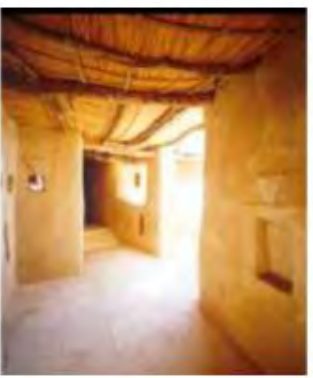
Figure 4. Roofing by Palm Rachis Adrere Amellal Eco-Lodge (Alamuddin, 2001)